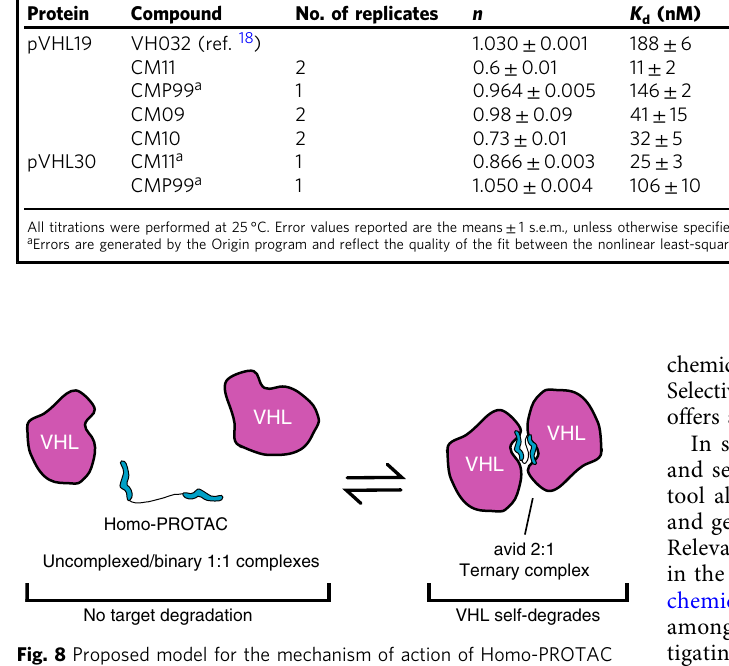
Table 1 Thermodynamic binding parameters of complex formation of Homo-PROTACs measured by isothermal titration calorimetry Protein Compound